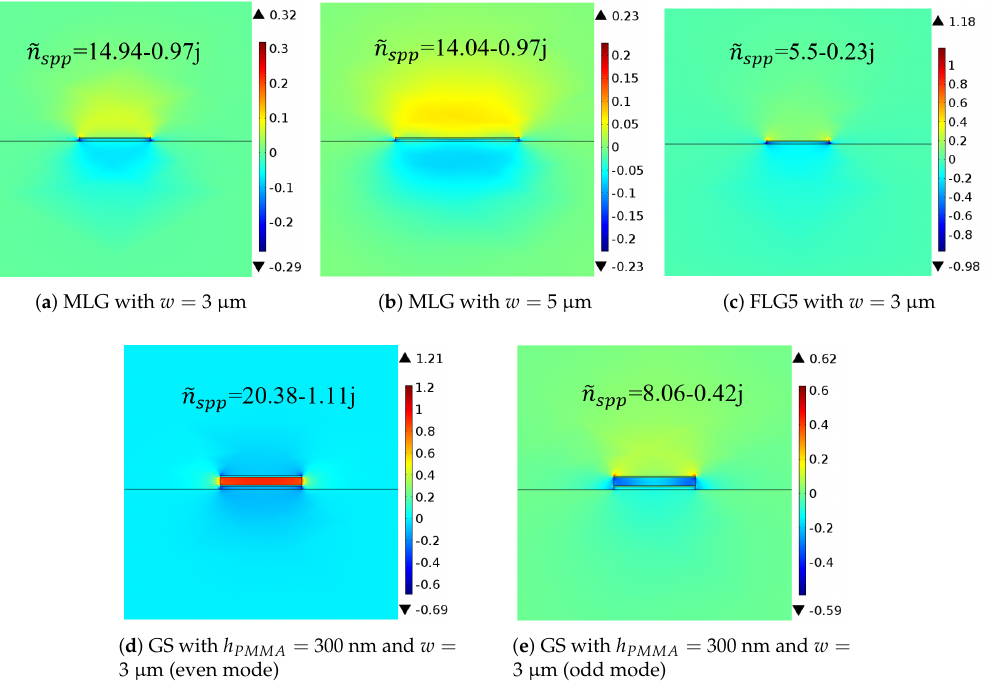
Figure 3. Normal electric fields and effective refractive indices of different structures with µ c = 0.5 eV at 3